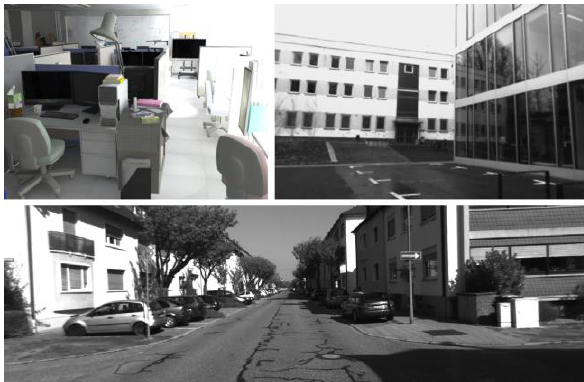
Figure 2. Example images from New Tsukuba (upper left), own stereo data (upper right) and KITTI